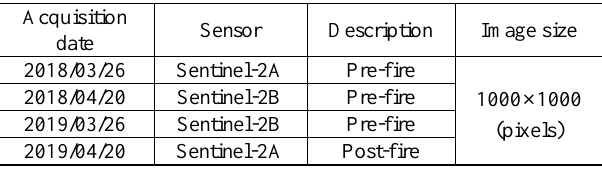
Table 1. Specifications of images used in this study Band number and